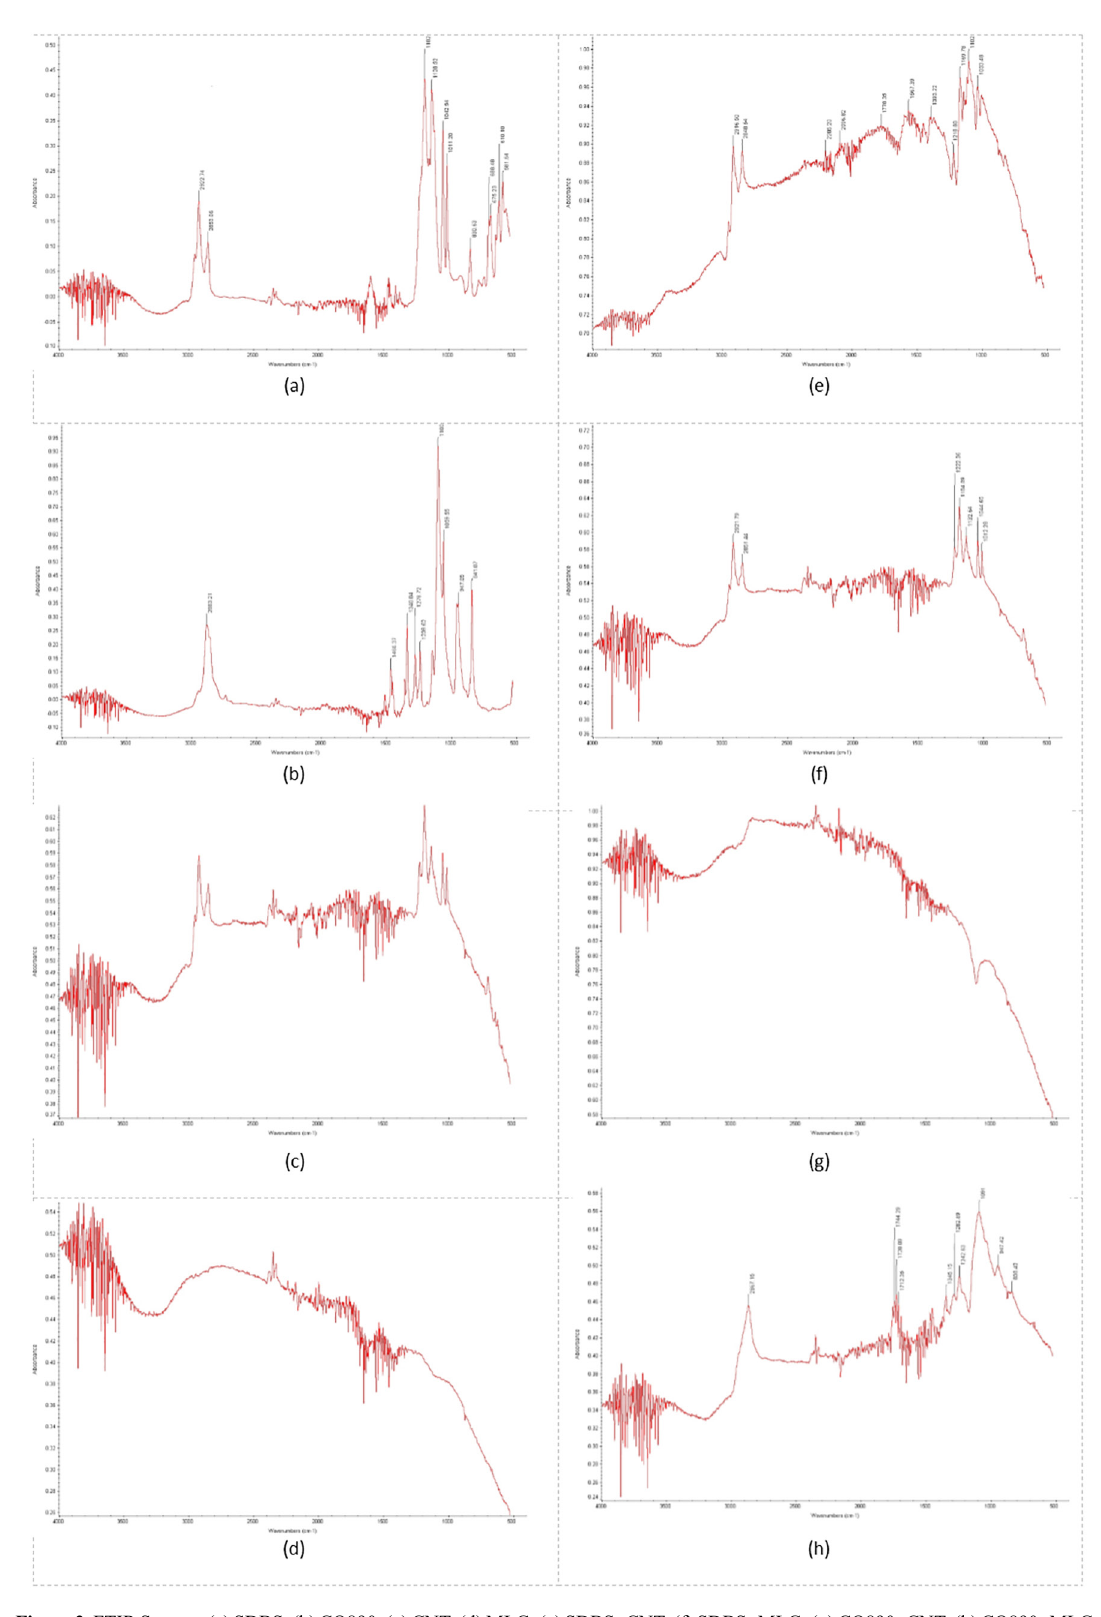
Figure 2. FTIR Spectra. (a) SDBS; (b) CO890; (c) CNT; (d) MLG; (e) SDBS+CNT; (f) SDBS+MLG; (g) CO890+CNT; (h)